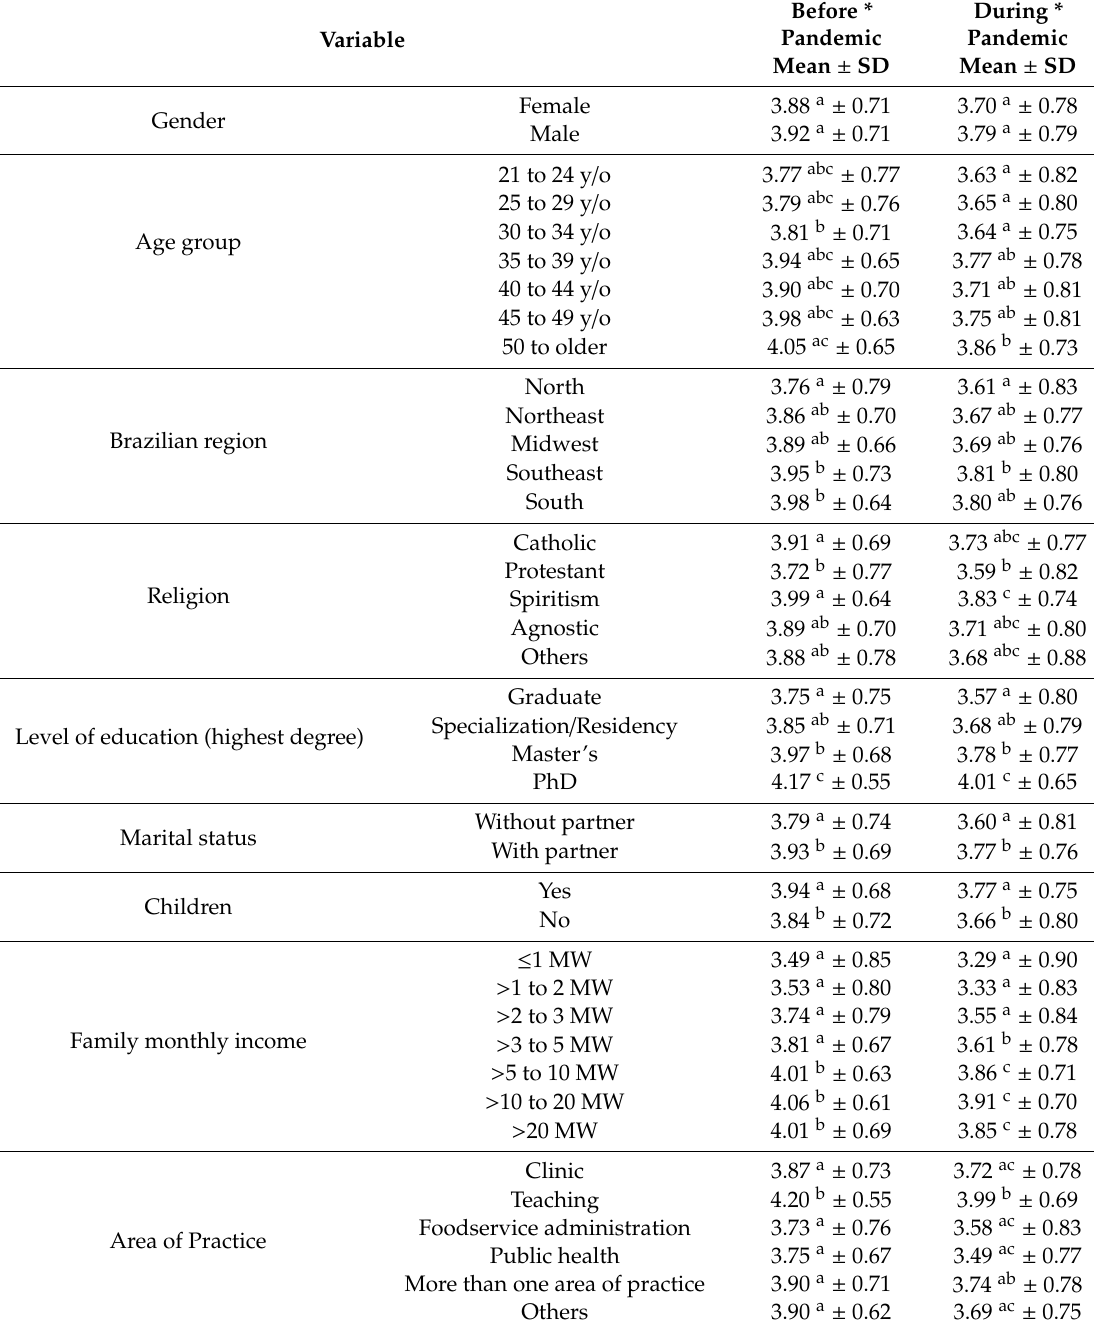
Table 2. Wellbeing at work by socioeconomic and demographic variables of Brazilian dietitians before and during the pandemic period ( n =